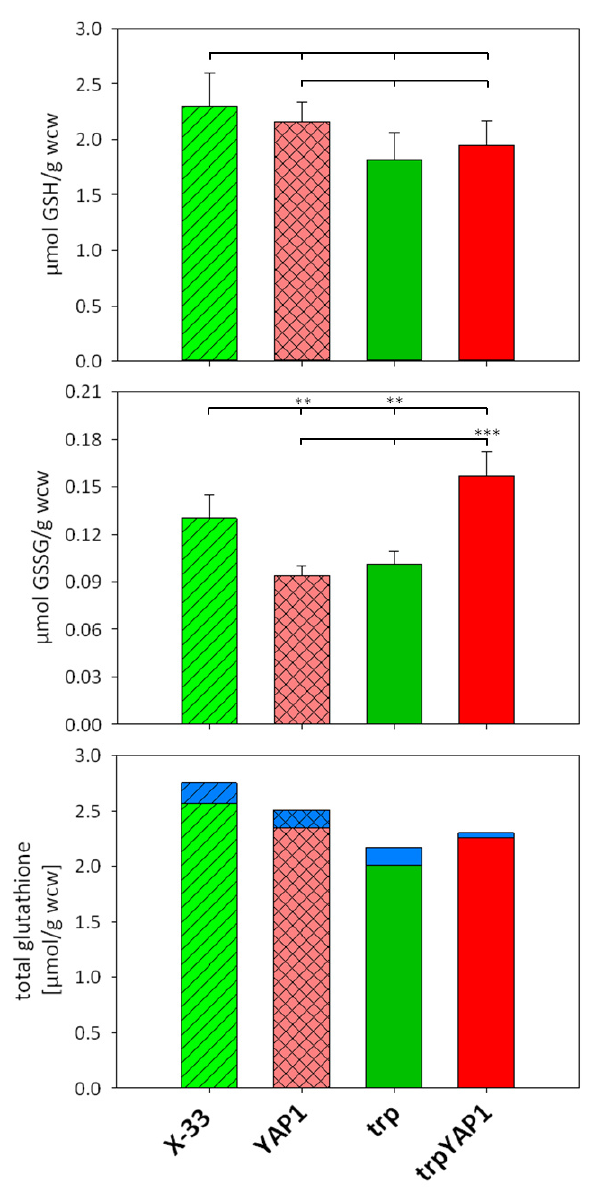
FIGURE 2: Comparison of intra- and extracellular glutathione (GSH) and glutathione disulfide (GSSG) levels in YAP1 over- expressing P. pastoris and controls. Upper panel: Intracellu- lar GSH concentrations (µmol GSH per gram wet cell weight). Differences were not statistically significant (P-values > 0.1). Middle panel: Intracellular GSSG concentrations (µmol GSSG per gram wet cell weight). ** in the upper row indicate a sig- nificant difference to X-33 (P < 0.05). *** in the lower row in- dicates a significant difference to the trp strain (P < 0.01). Lower panel: Total glutathione (tGSH) concentration (intracel- lular: green (controls) or red ( YAP1 overexpressing strains), excreted: blue) was determined using the equation t GSH = [GSH] + 2*[GSSG]